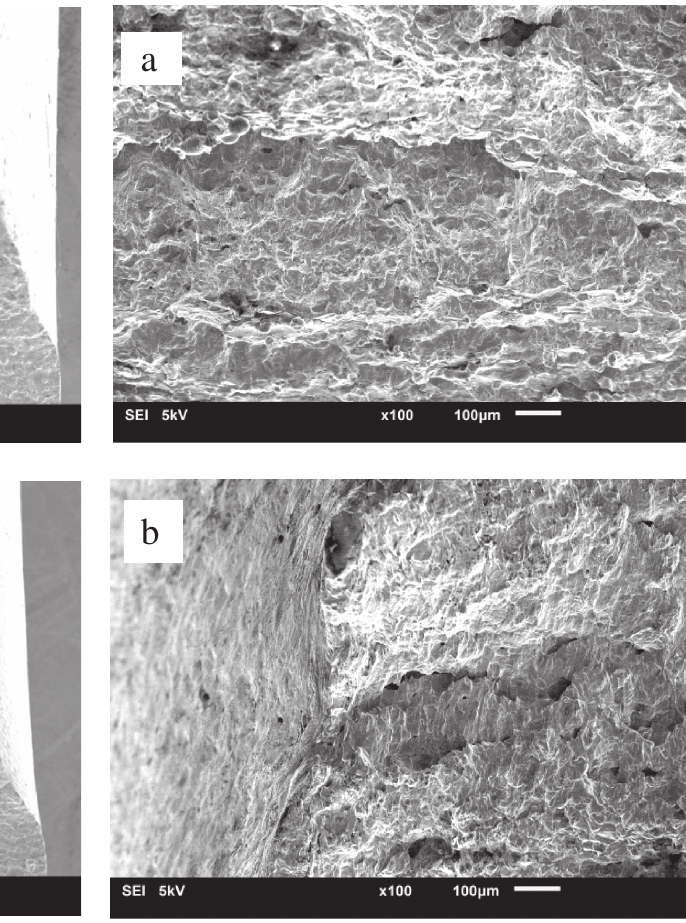
Figure 9: SEM images of crack source. (a) Fracture of impact sample before LSP; (b) Fracture of impact sample after